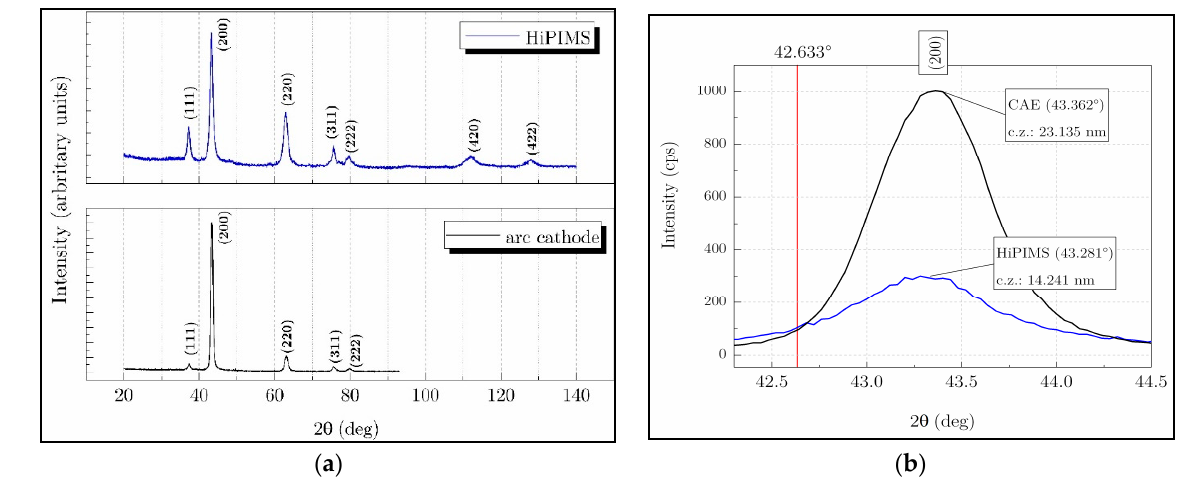
Figure 4. XRD data of the coatings studied: ( a ) phase composition; ( b ) full width at half maximum (FWHM) data.